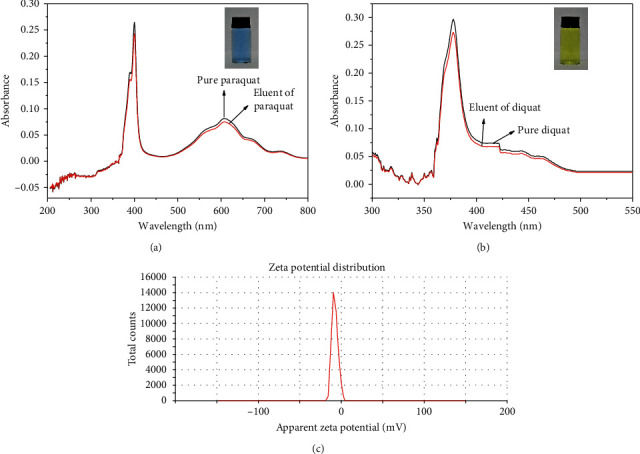
(a) The UV spectrogram of PQ-NaOH-Na2S2O4 and eluent-Na2S2O4; the insert image is blue free radicals of paraquat. (b) The UV spectrogram of DQ-NaOH-Na2S2O4 and eluent-Na2S2O4; the insert image is green free radicals of diquat. (c) The zeta potential of CoFe2O4@SiO2 NPs.